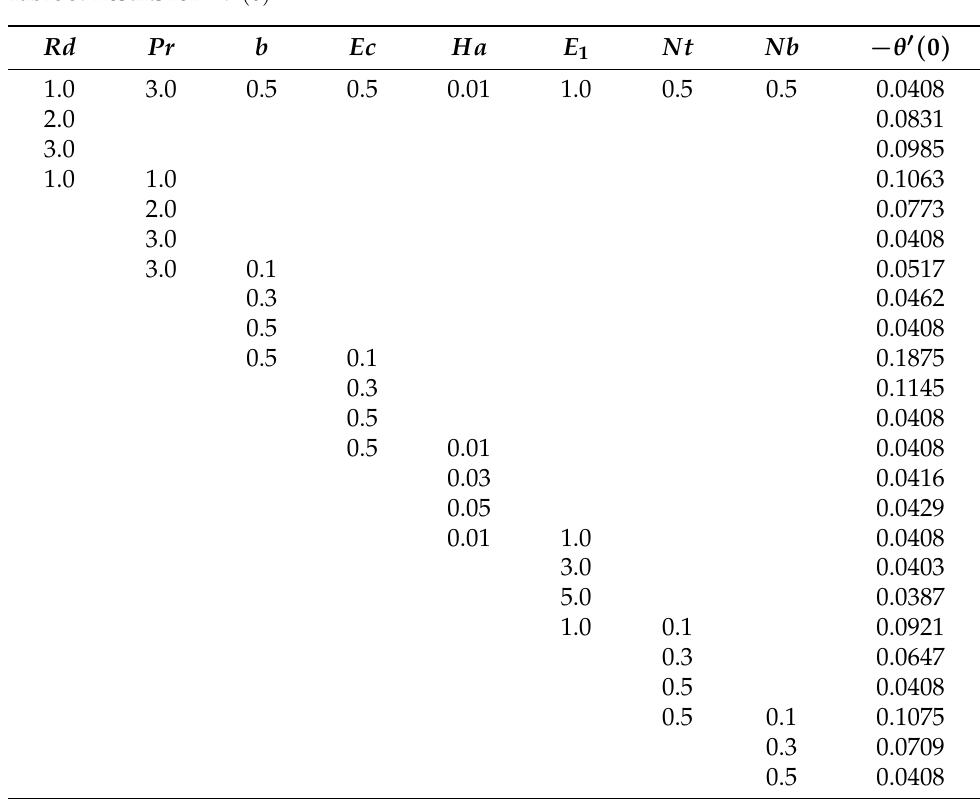
Table 3. Results for − θ (cid:48) ( 0 )